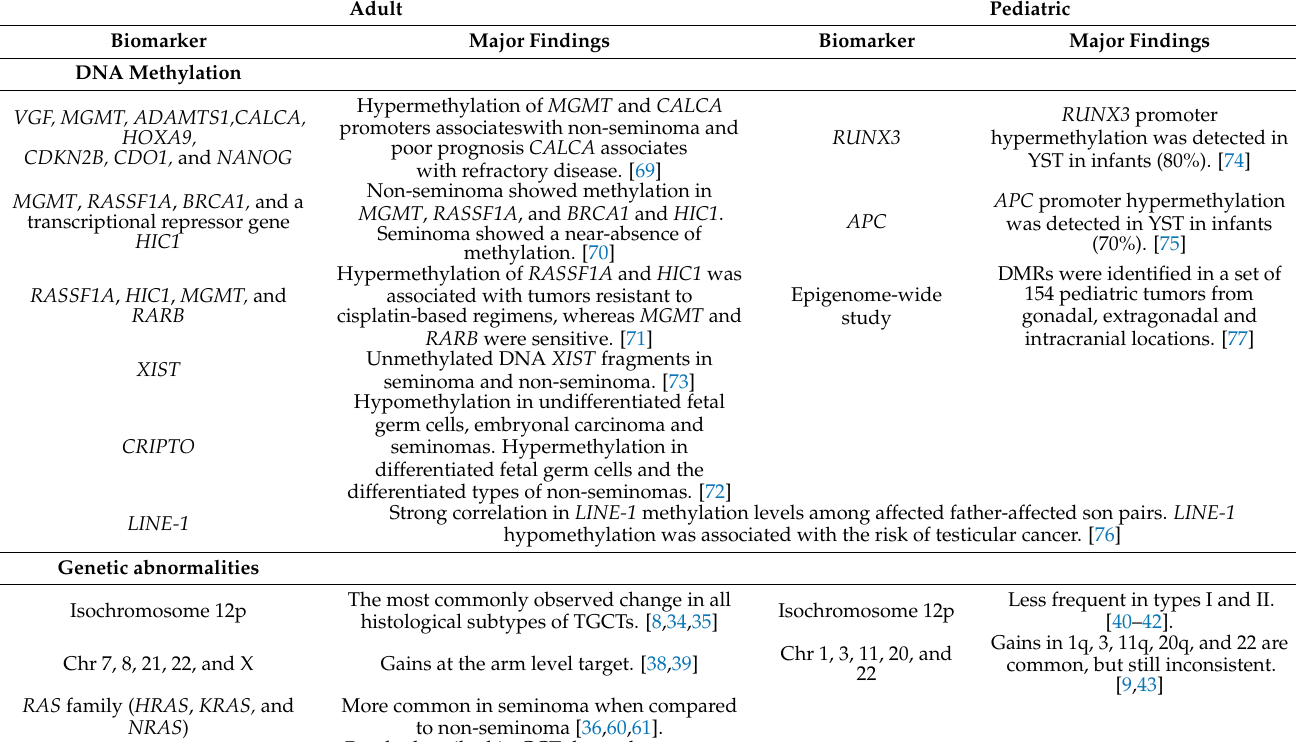
Table 1. Epigenetic-based biomarkers in testicular germ cell tumors in adult and pediatric patients.